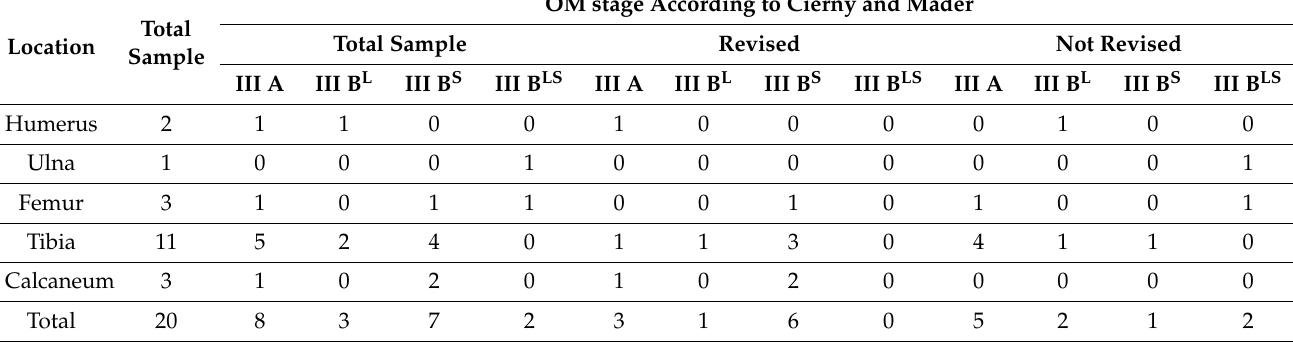
Table 2. Location and type of chronic